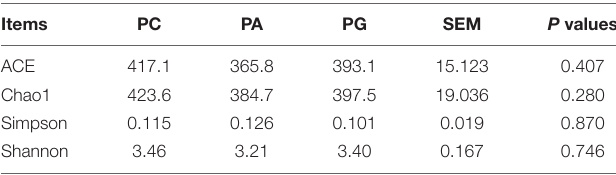
TABLE 9 | Effects of B. licheniformis and enramycin on concentration of short-chain fatty acids in cecal content of 42-day-old broilers (mg/kg). Items PC SEM